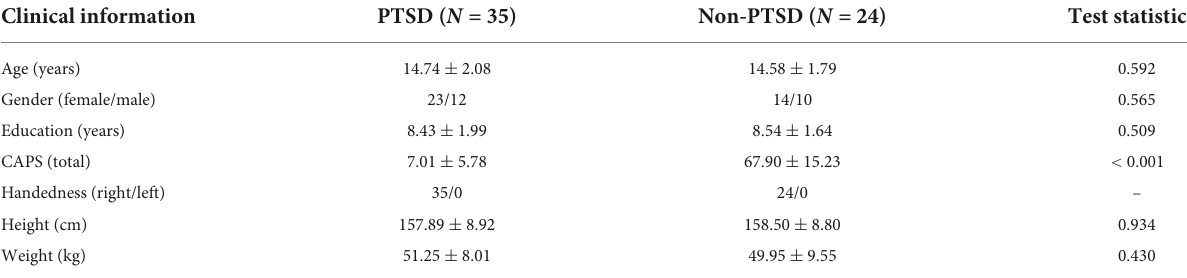
TABLE 1 Sample characteristics.